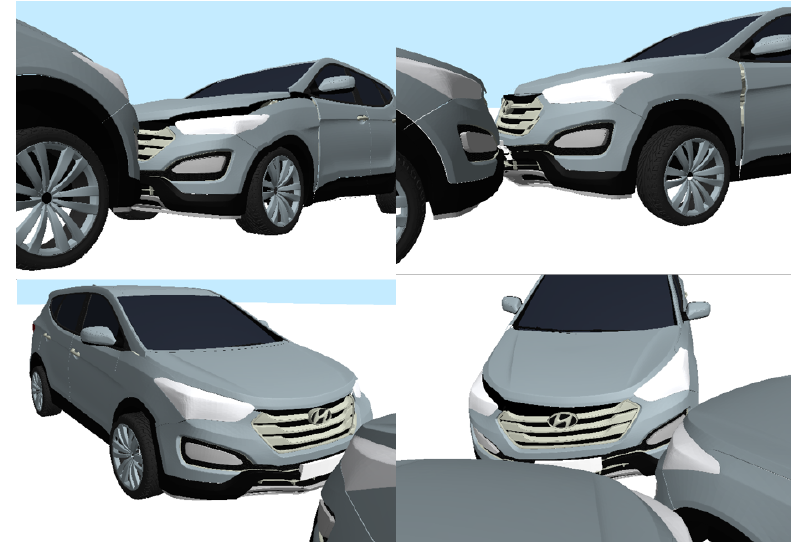
Figure 11. Comparison between deformed bumper without translated wheels ( left ) and with translated wheels ( right ).